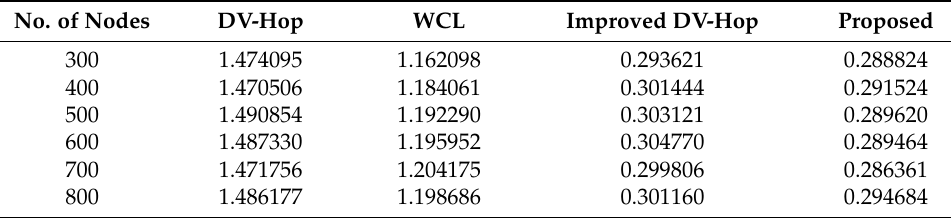
Table 9. Comparison of localization error using various total numbers of nodes.